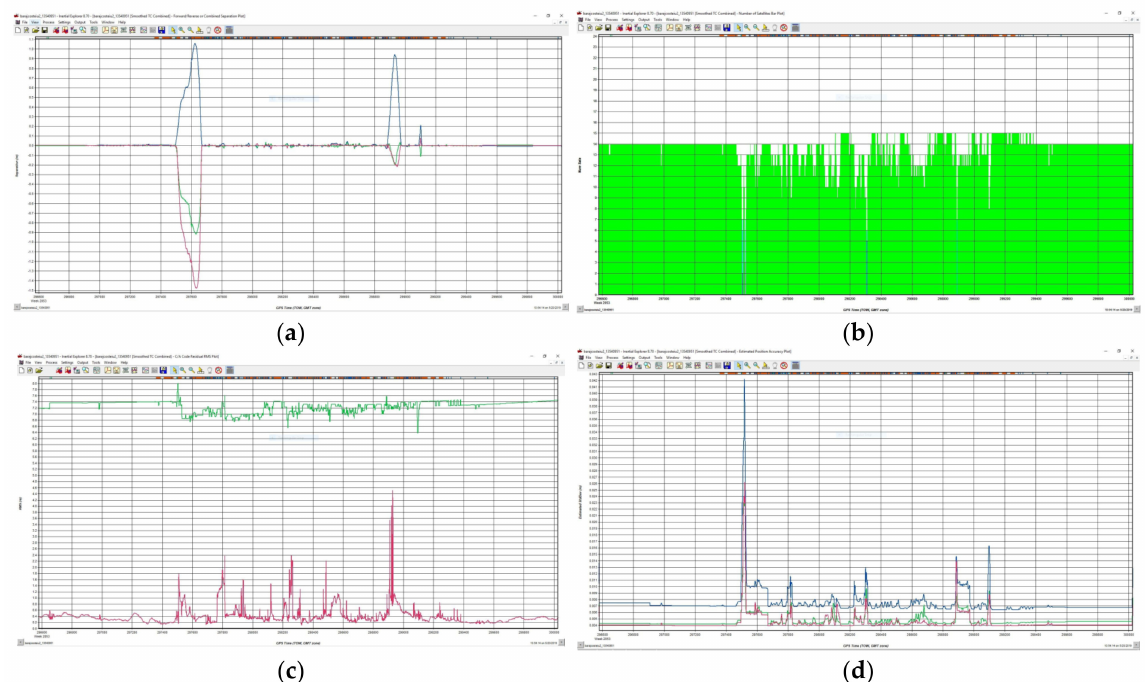
Figure 27. 3D scanning of the objective NH Costeiu–Dam on 15.05.2019: ( a ) View of scan accuracy (Combined separation); ( b ) The number of visible satellites at the time of the scan; ( c ) RMS values; ( d ) Estimation of data accuracy (X, Y, Z and Time).